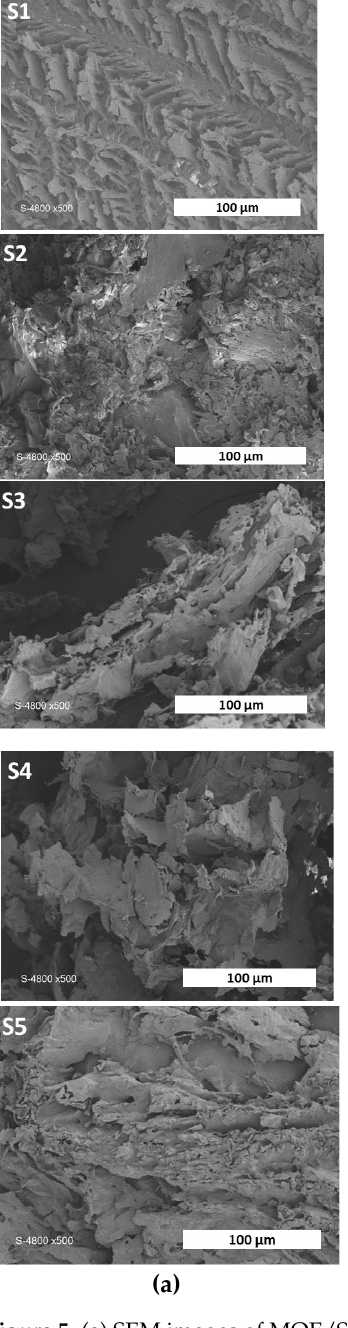
Figure 5. ( a ) SEM images of MOE/SA/PVA S1–S5 (scale bars: 100 μm), ( b ) SEM images with high magnification (scale bars: 15 μm).